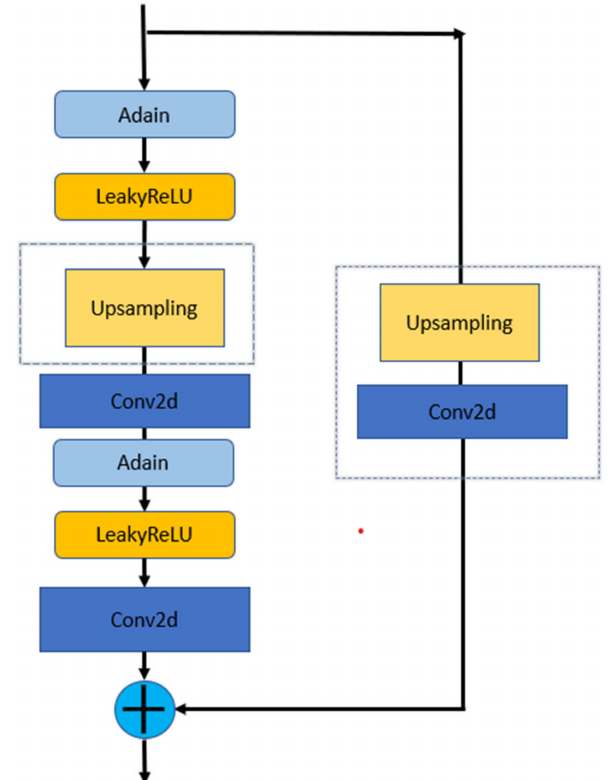
Figure 4. AdainResBlk block (the part within the dashed line indicates whether the judgment is executed or not).